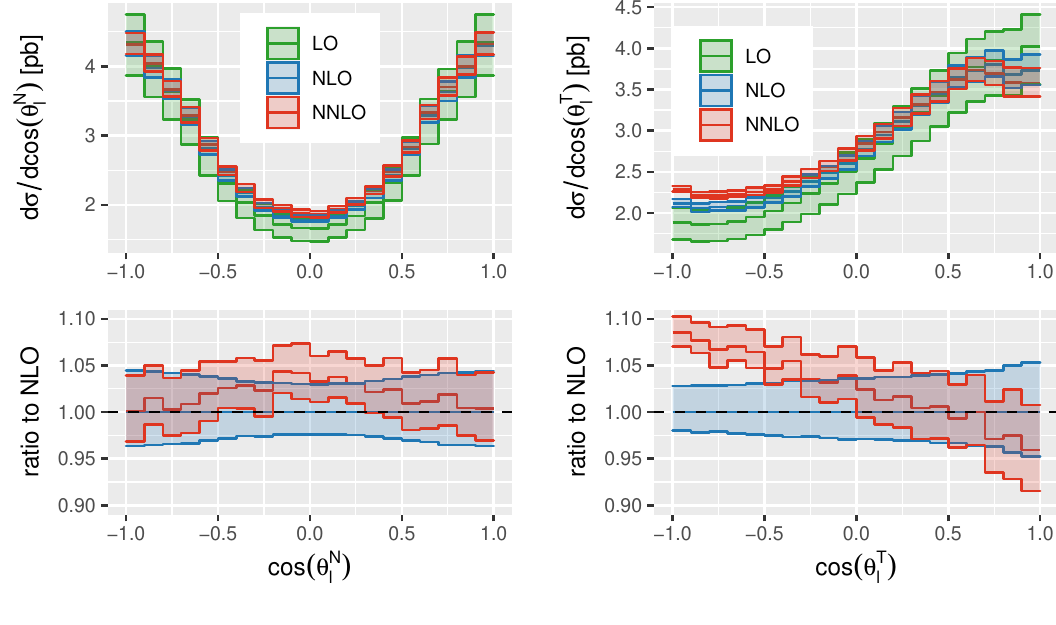
Figure 21 . Angular distributions for cos θ N